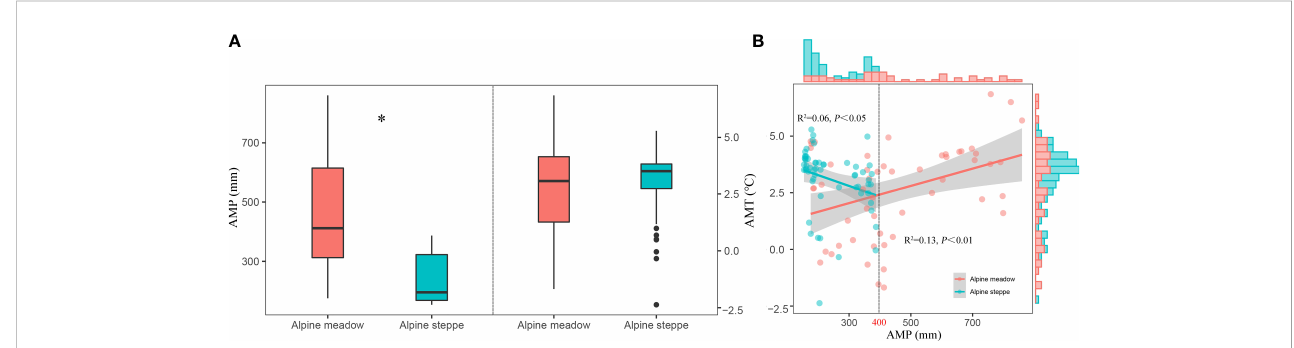
FIGURE 4 The differences of AMP and AMT (A) and their correlations in alpine steppe and alpine meadow (B) . AMP and AMT represent annual mean precipitation and annual mean temperature, respectively. * represents P< 0.05.